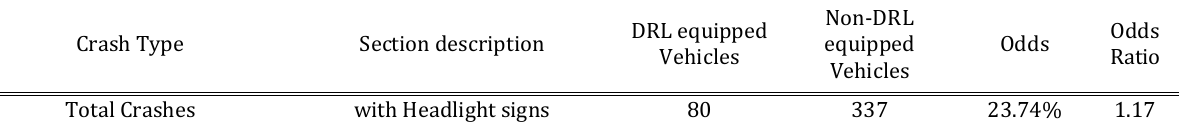
Table 6: Two-Way Contingency Table with Odds and Odds Ratio for Total and Target